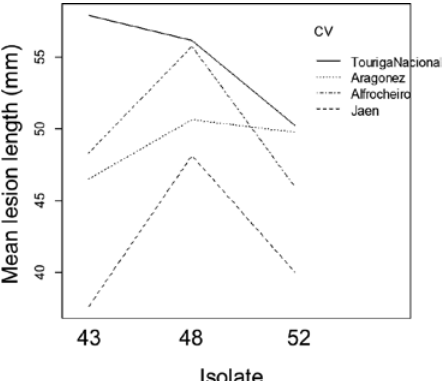
Figure 6. Mean lesion lengths (mm): trends for three isolates (43, 48 and 52) and four grapevine cultivars (Alfrocheiro, Aragonez, Jaen and Touriga